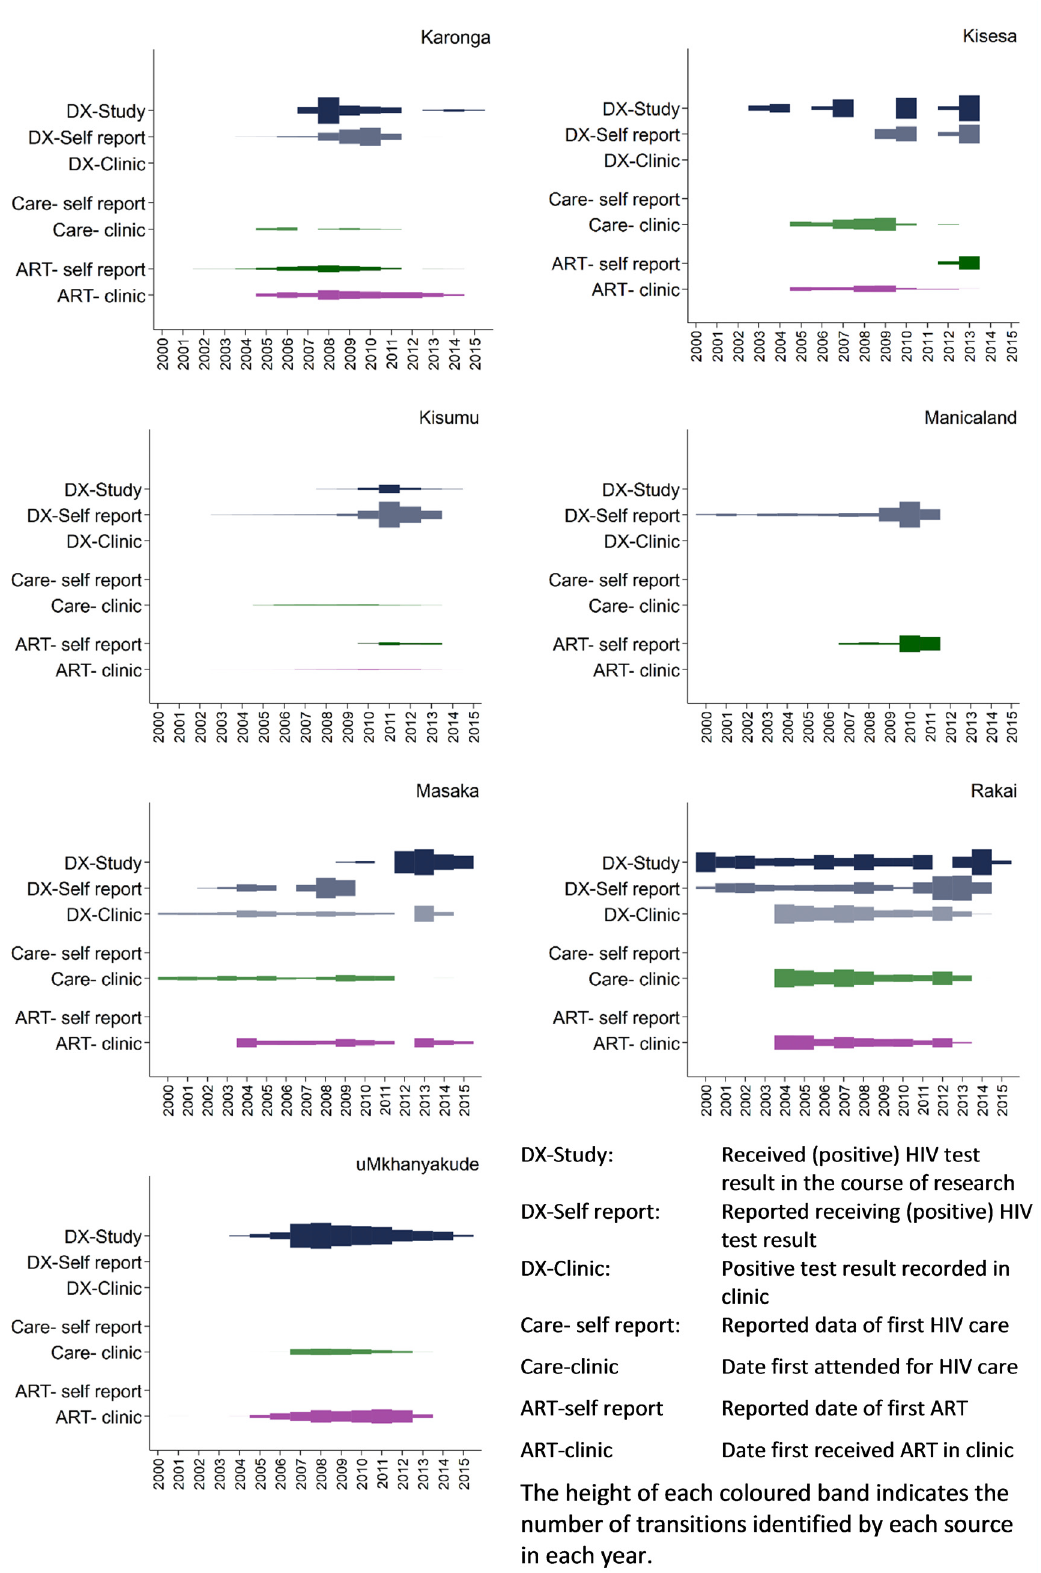
Figure 2. Data available from each study by data source and continuum stage, over